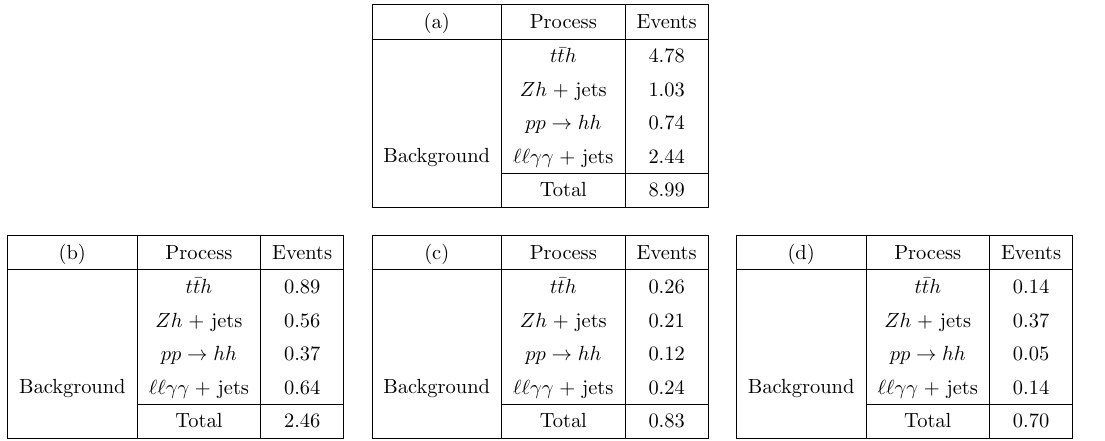
Figure 25 . Upper limit on (cid:27) ( pp channel. The solid (dashed) lines show the 2 (cid:27) -5 (cid:27) band on taking 0% (5%) systematic uncertainties.